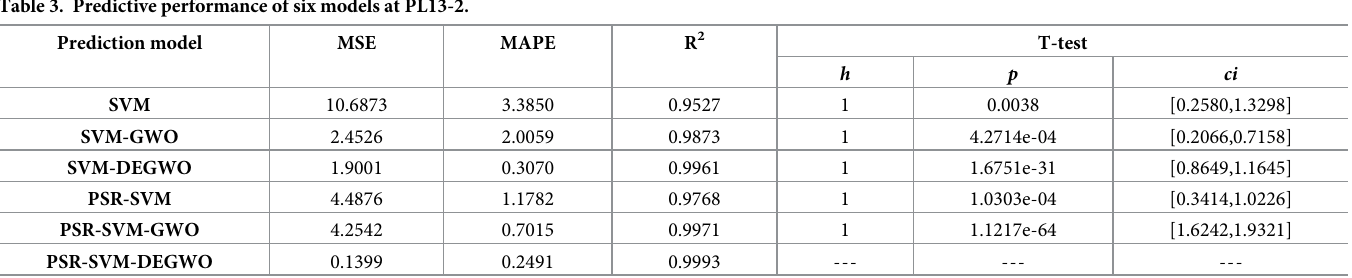
Table 3. Predictive performance of six models at PL13-2. Prediction model